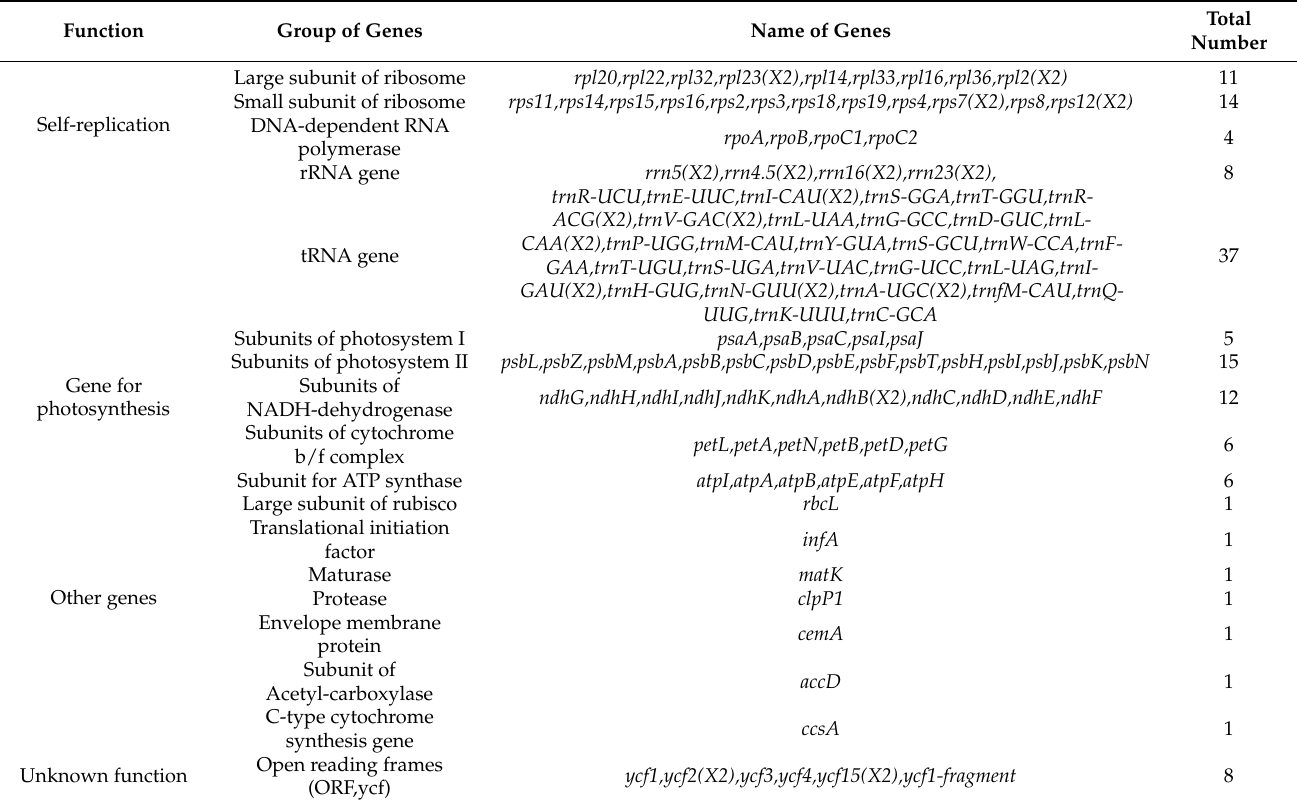
Table 2. List of genes in the chloroplast genome of E. fortunei